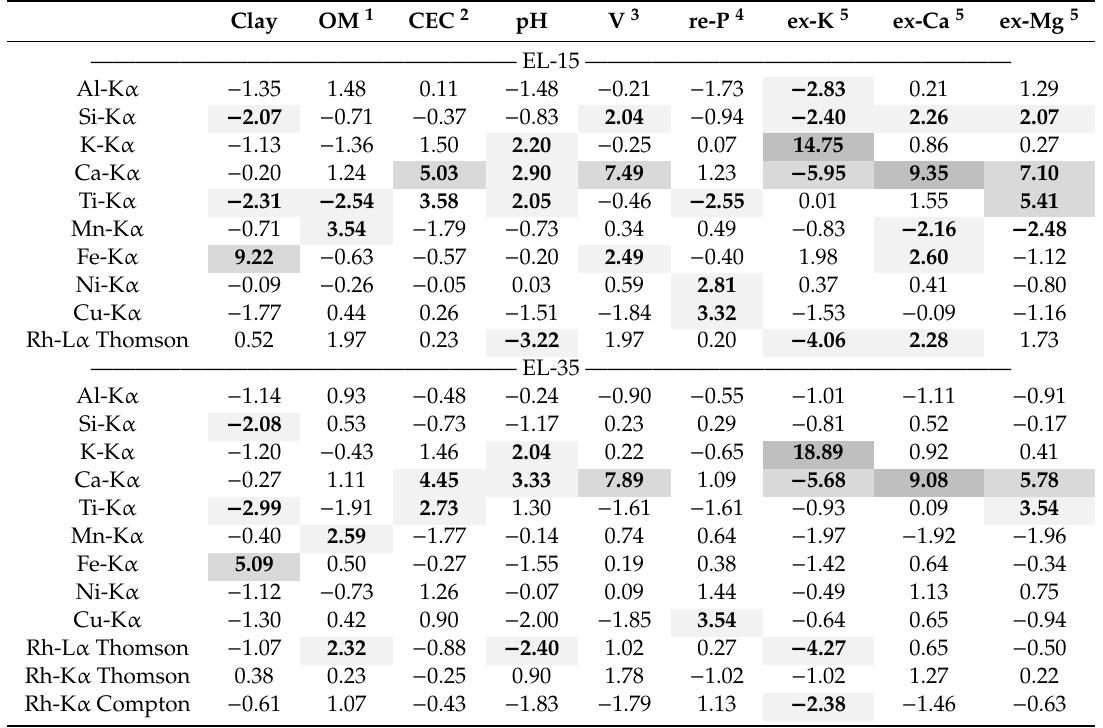
Table 4. Importance of X-ray fluorescence (XRF) variables for the prediction of studied soil fertility attributes, using the two XRF tube voltage data scenarios of EL-15 and EL-35, designated as EL-15 and EL-35, respectively. The values presented correspond to the t-value for each standardized coe ffi cient obtained in the regressions calibration.